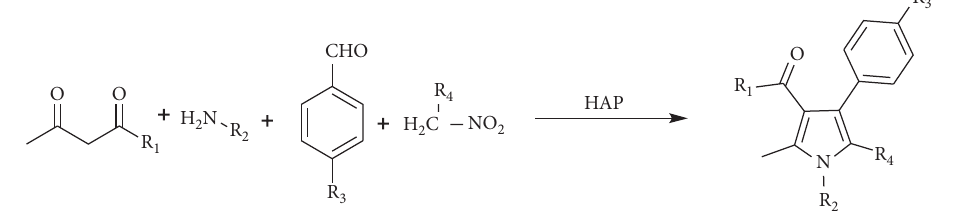
Scheme 4: Multicomponent synthesis of pyrroles by various substrates.